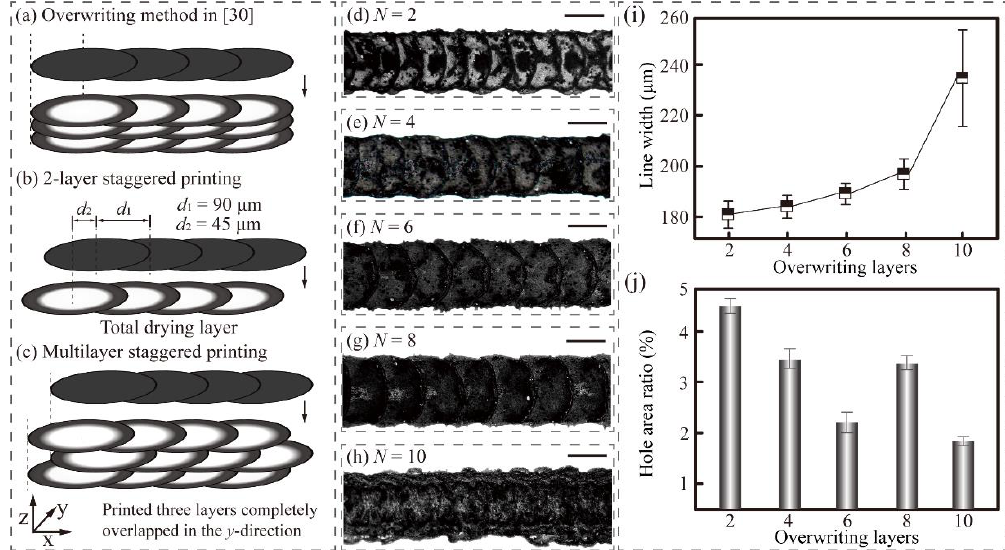
Figure 7. Effect of overwriting layers on the morphologies of printed CNT lines. ( a – c ) Schematic illustration of CNT line printing and staggered overwriting printing. ( d – h ) Optical microscope images of printed CNT lines with different numbers of layers (2 to 10 layers). All CNT lines were printed within 1 min after each PVA film ’ s heat treatment. All scale bars are 110 μm. ( i ) Effect of the number of layers on the line width. ( j ) Effect of the number of layers on the ratio of the hole area to the line area.